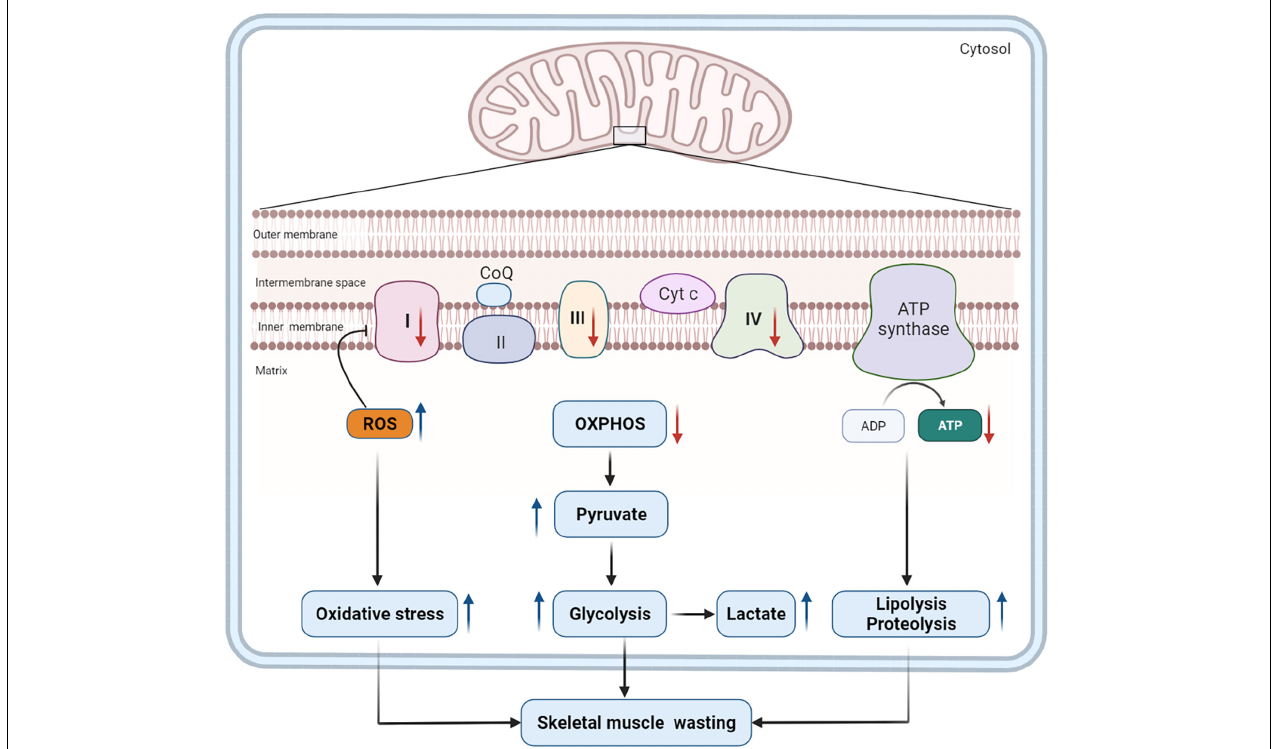
FIGURE 1 | Mitochondrial dysfunction and its impact on catabolism. Mitochondrial dysfunction in PICS decreases the production of ATP by inhibiting the expression and activity of some key enzymes in the ETC (complexes I, III, and IV) (130). Consequently, pyruvate is unable to generate energy through the OXPHOS but does so through glycolysis, and the levels of lactate and pyruvate increase as a result. Mitochondrial dysfunction also contributes to the overproduction of ROS, which, in turn, will inhibit the expression and activity of ETC complexes. Excessive ROS induces oxidative stress, which is harmful to skeletal muscle proteins. To meet tremendous energy demands under the condition of mitochondrial dysfunction, the body has to alter metabolic pathways and intensify the catabolism of macronutrients. These pathophysiological changes will contribute to long-term skeletal muscle wasting in patients with PICS. ROS, reactive oxygen species;